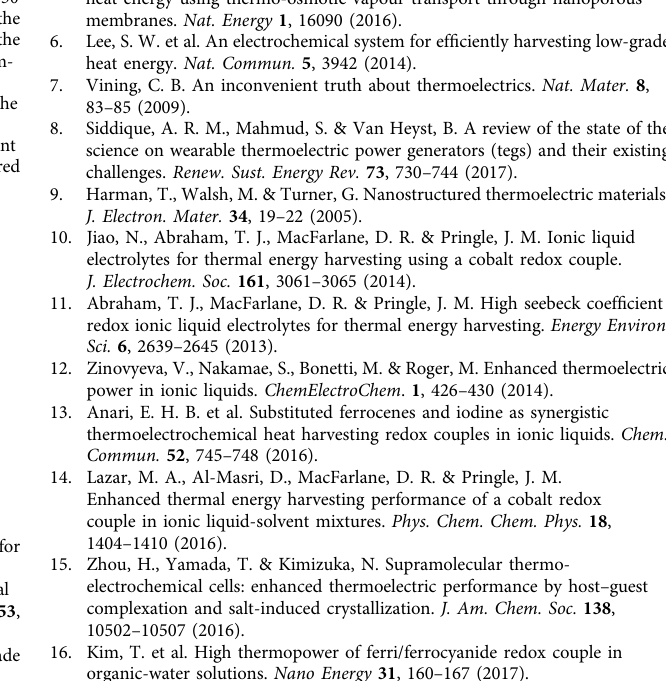
were fi rst fi xed to one side of the polyamide frame with epoxy glue. Then, the cells were fi lled with the electrolyte. Finally, all cells were sealed with an additional 50 graphite electrodes. The cells were connected in series by Cu wires. To prevent the leakage, the whole module was sealed by epoxy resin glue. As shown in Fig. 4a, the module was sandwiched between two aluminum (Al) heat exchangers. The tem- perature difference across the module was created by pumping circulating hot water (333K) and cold water (278K) in the two heat exchangers. The V oc of the cells was measured with a Keithley 2000 multimeter, and the corresponding temperature difference was recorded by a thermocouple data logger. The current was measured with a Keithley 2400 instrument. The LED array consisted of 29 red LED lamp beads in parallel.